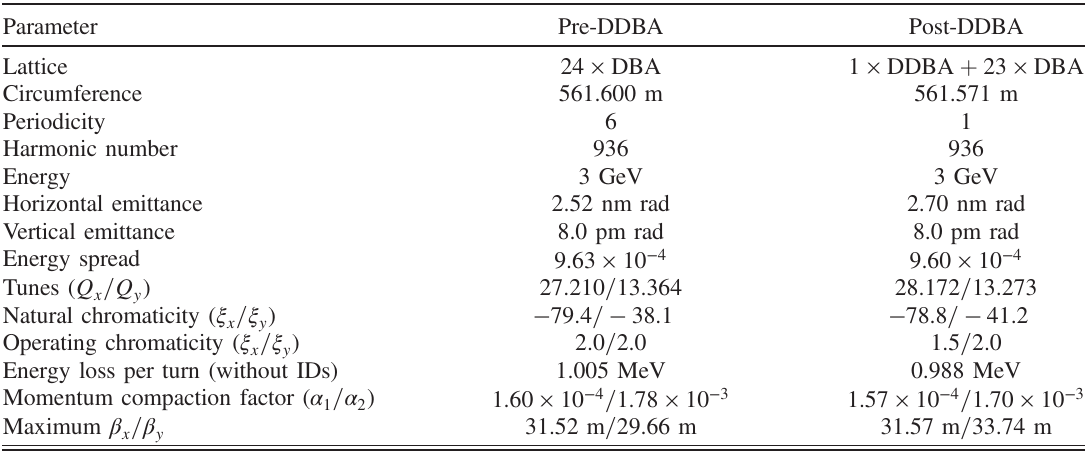
TABLE I. Comparison of main lattice parameters before and after the installation of the DDBA cell.